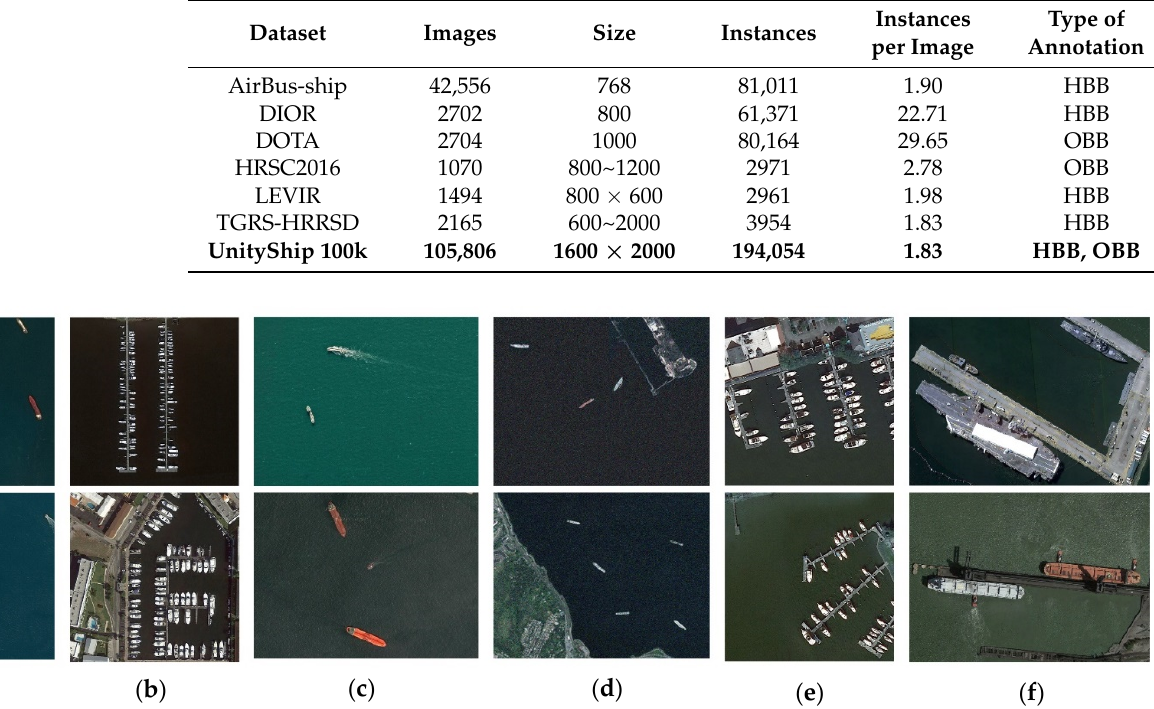
Figure 9. Examples of real-world aerial image datasets for ship recognition. From left to right: ( a ) AirBus-Ship, ( b ) DOTA,